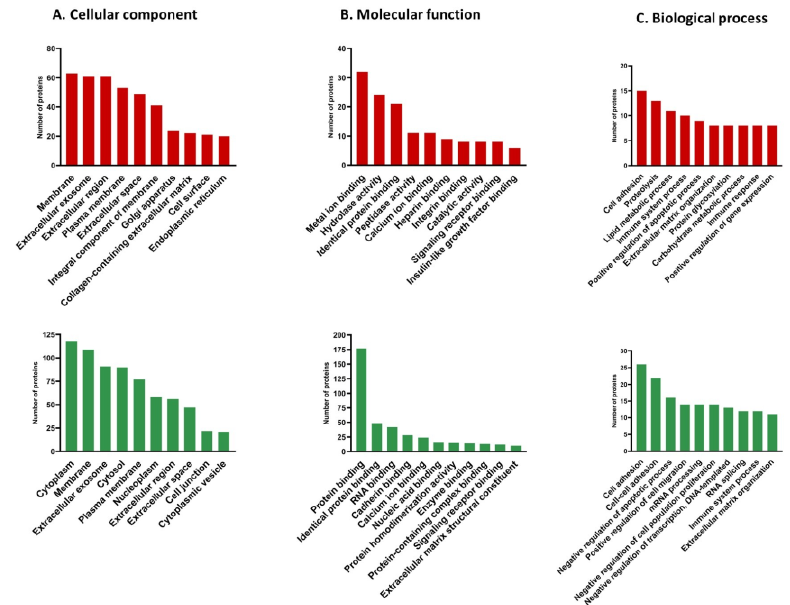
Figure 4. Gene ontology analysis of differentially expressed proteins: ( A ) cellular components, ( B ) molecular functions, and ( C ) biological processes of upregulated (red bars) and downregulated (green bars) proteins from EVs of cervical cancer.